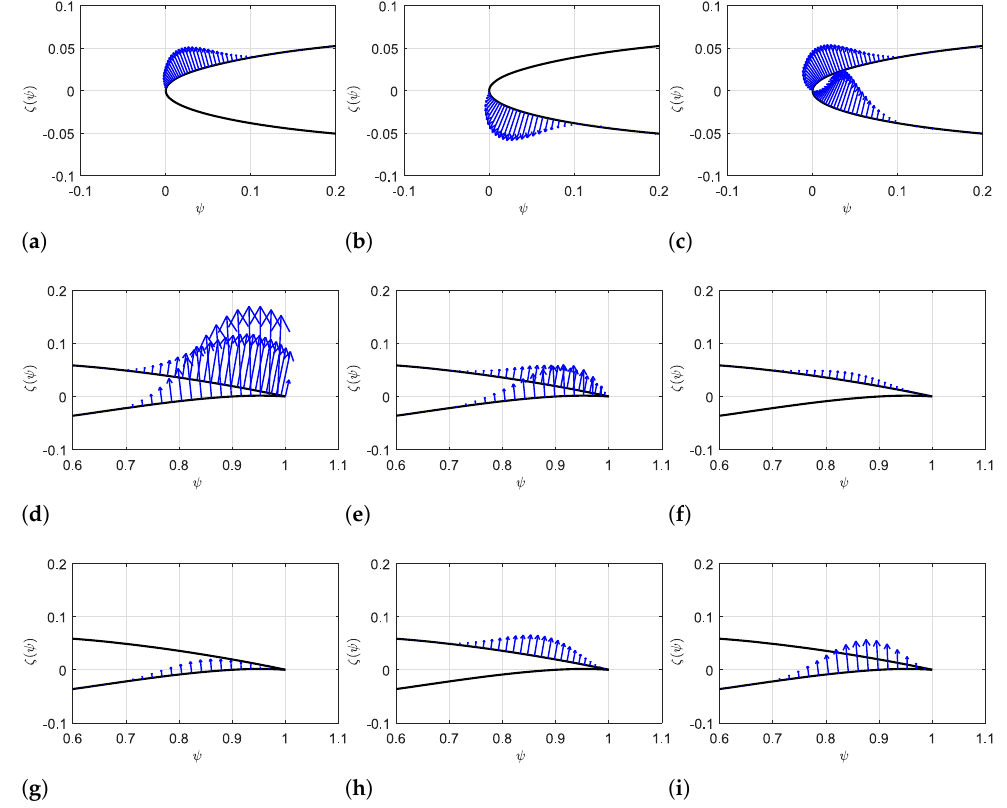
Figure 6. Geometric sensitivities of morphing leading and trailing edges. Geometric sensitivities of morphing leading edge with respect to R u , R l , and z LE , whose amplitudes have been multiplied by a factor of 20 for better demonstration. The amplitude of z TE has been multiplied by a factor of 10, and the magnitudes of β , A u8 , A l8 , A u9 , and A l9 have been multiplied by a factor of 100. ( a )